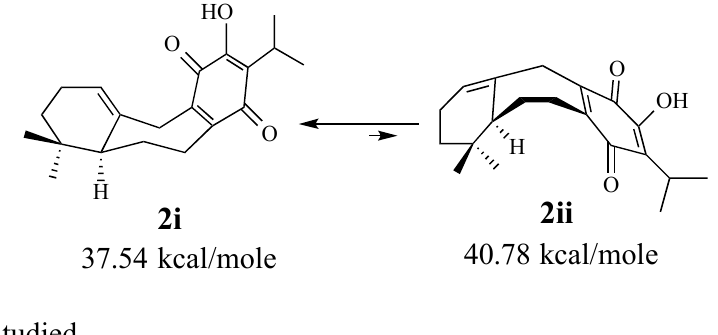
Figure 1. MM3 calculations of two conformations of quinone 2